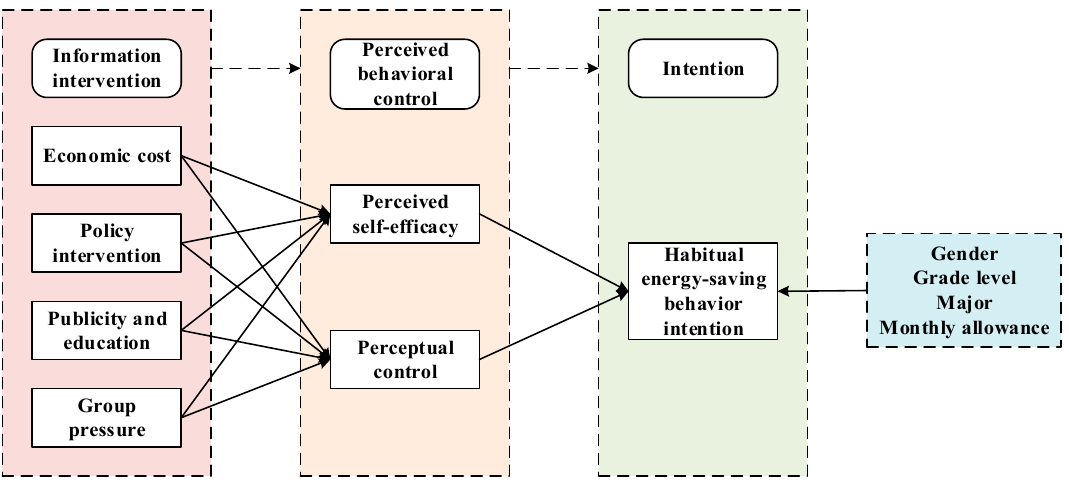
Figure 1. Research model on the influence of information intervention on college students’ behavioral intention to save energy.